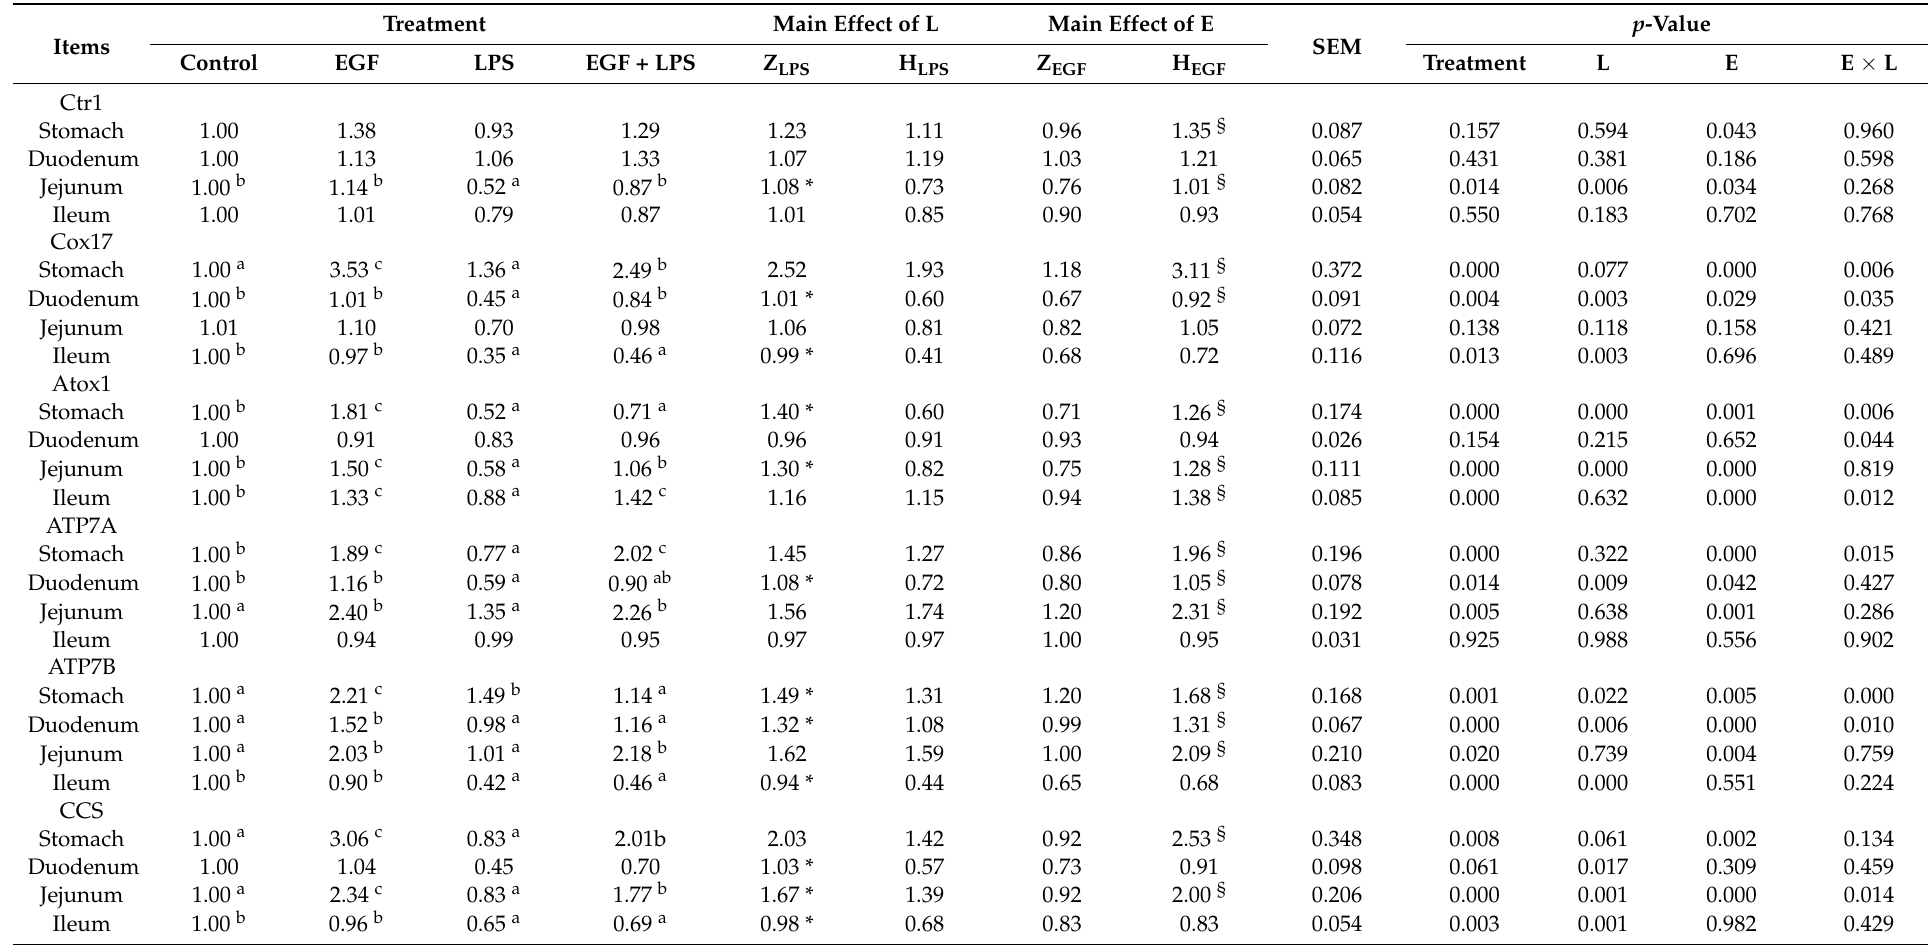
Table 6. EGF attenuates the effect of LPS on the expression levels of Cu transport-relative genes in the mucosa of gastrointestinal tract of early-weaning